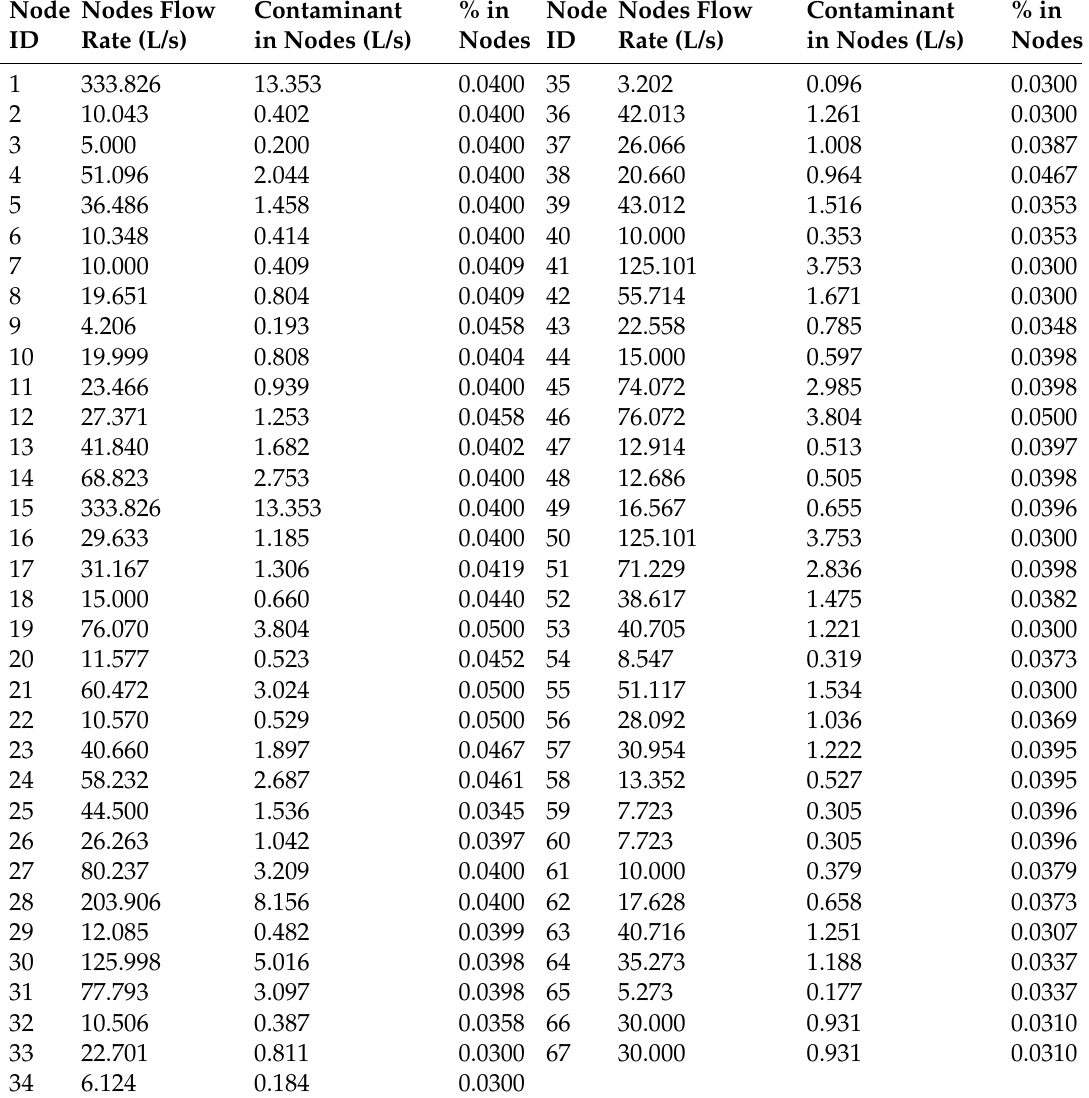
Table 7. Numerical results of node and contaminant flow for Illustrative Example